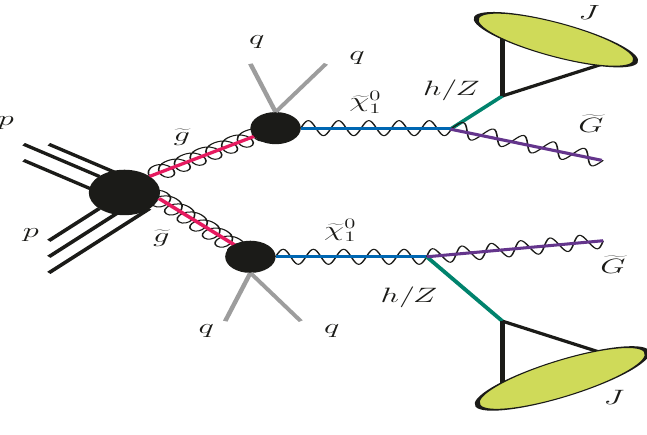
Figure 7 . Representative diagram for the signal